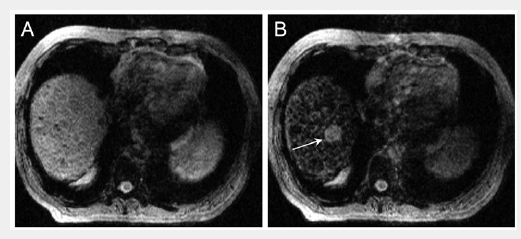
Iron oxide nanoparticles as RES contrast media for MRI. MR images of the hepatic dome before (A) and after injection of iron oxide nanoparticles (Ferumoxide: 1.4 ml) (B). The lesion (arrow) is clearly visible after injection of the iron oxide nanoparticles, but not before. The increase of contrast between the lesion and the liver is due to a darkening of the normal liver. Moreover, please note the heterogeneous aspect of the liver, corresponding to cirrhosis. In this context, the hepatic nodule is highly suspect of a hepatocellular